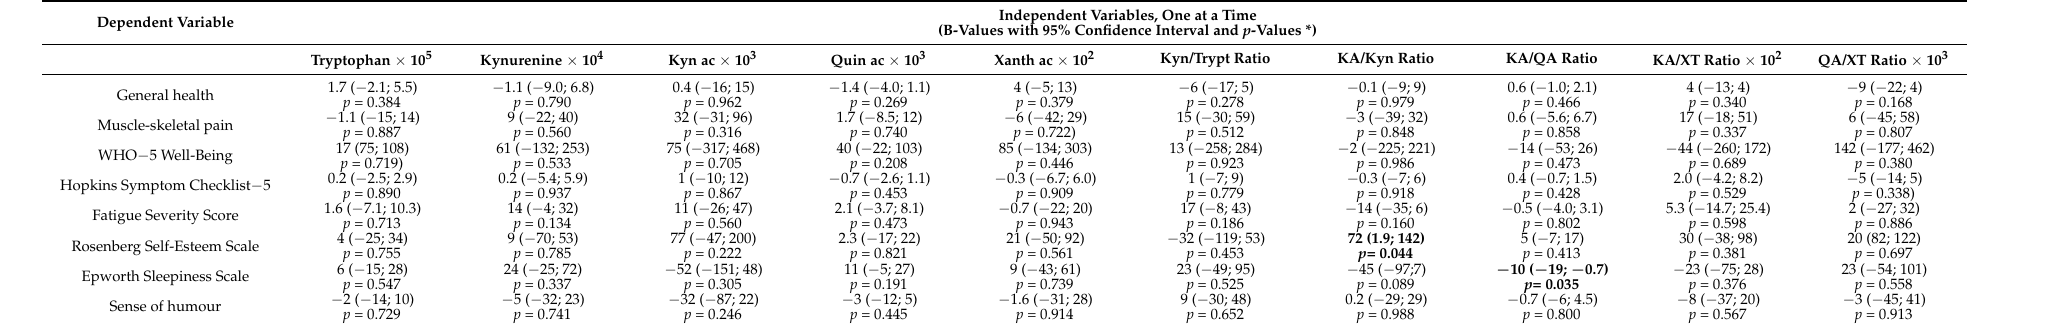
* q -values. All p -values in the table were adjusted for multiple testing ad modum Benjamini–Hochberg. The adjusted p -values are referred to as q -values. Only q -values < 0.10 are given in the table. p and q -values < 0.05 are marked in boldfaced type. Table 3. Mixed linear regression model with the psychosomatic disorders as dependent variables (one at a time) and tryptophan, kynurenine, and the metabolites (one at a time) as independent variables adjusted for: Gender, Age, BMI, Smoking, Physical activity, CRP, Diabetes, Time (before/after). After adjusting for multiple testing, there were no statistically significant q -values